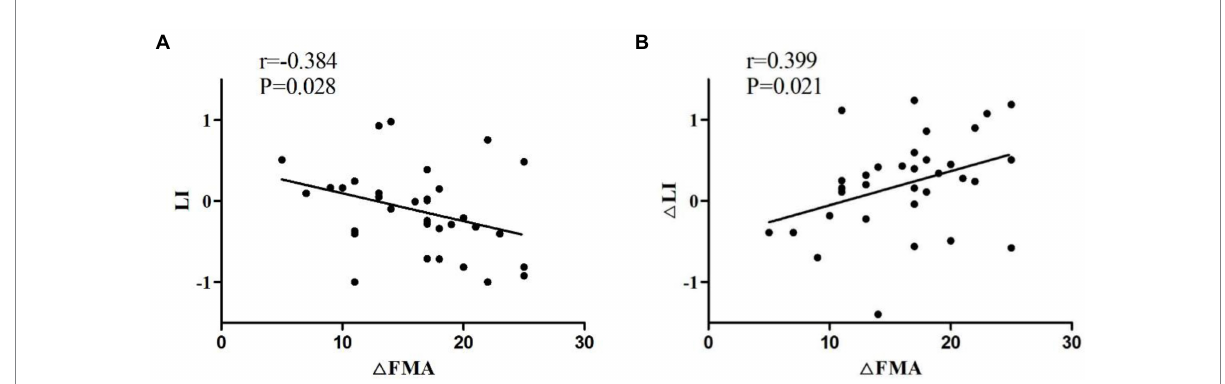
FIGURE 8 (A) Negative correlation of the LI of patients before treatment with ∆ FMA. (B) Positive correlation of ∆ LI with ∆ FMA. ∆ FMA, Mean increment of FMA-UE before and after 4 weeks of treatment; ∆ LI, LI difference between before and after 4 weeks after